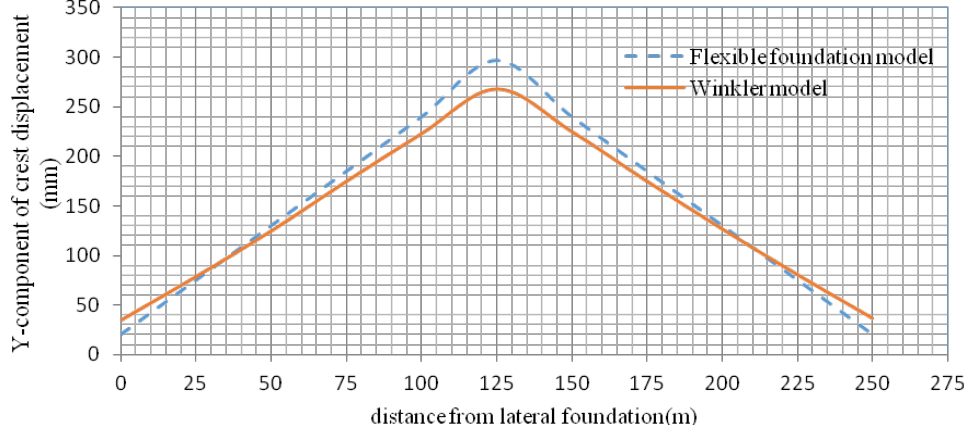
Fig. 2. The value of dam crest displacement in a perpendicular direction to dam body (y-direction) in arc dam crest (mm) against distance from lateral foundations (m).